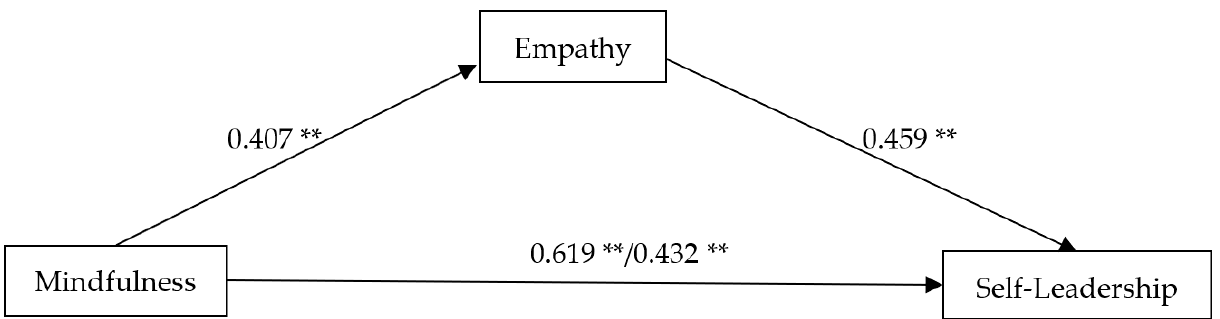
Table 3. Mediating effect of empathy between mindfulness and self ‐ leadership.